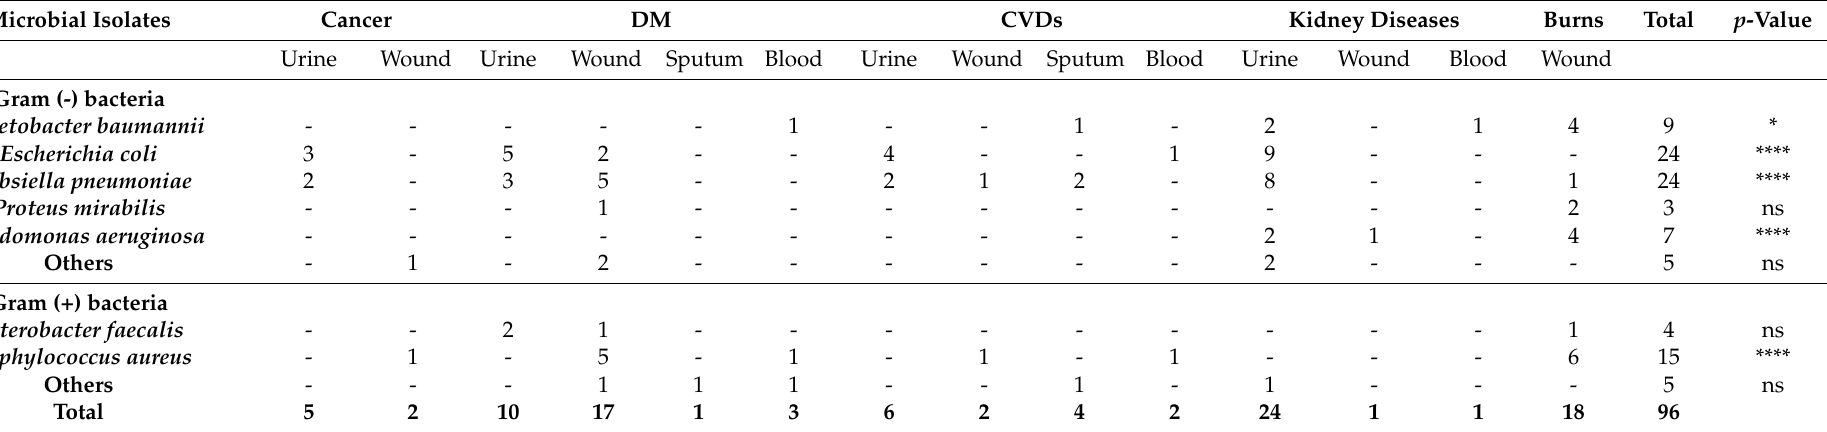
Table 2. Identified bacteria of positive bacterial culture tested specimens. Bacterial isolates ( n = 96) were divided into Gram-negative and Gram-positive bacteria, collected from different sites, including urine, wound, sputum, and blood, according to each represented disease (cancer, DM, CVD, kidney disease, and burn). Microbial Isolates